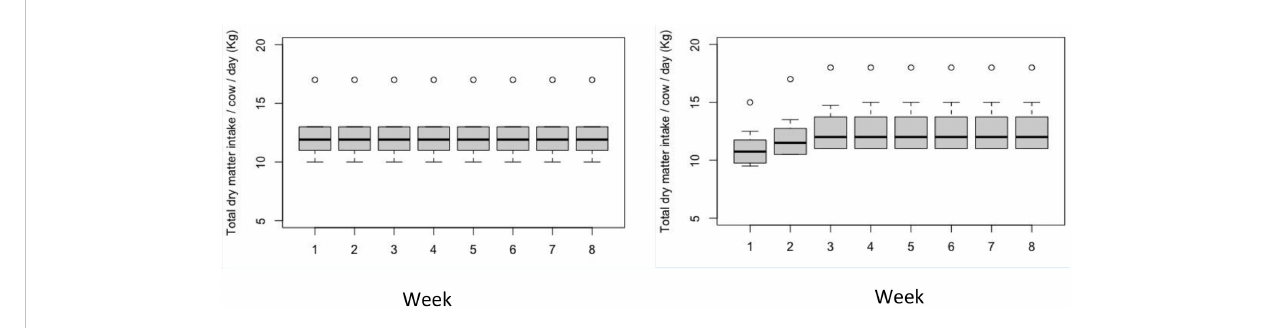
FIGURE 4 Comparison of effects of traditional feeding practice (left) and intervention diets (right) on dry matter intake